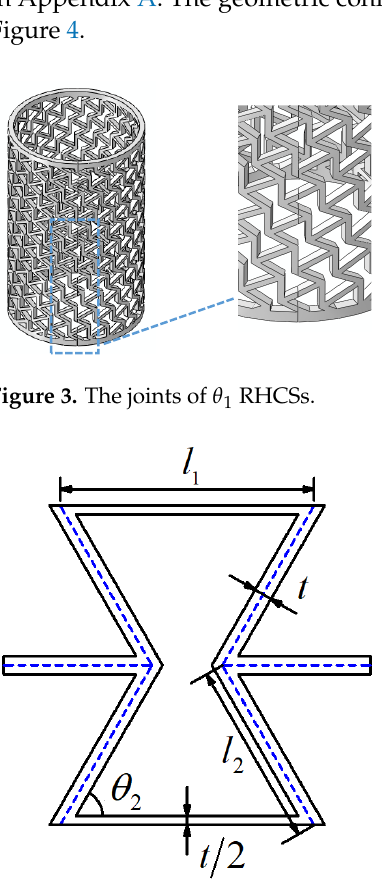
Figure 2. The process of constructing [ θ 1 / −θ 1 ] composite RHCS: ( a ) 0° re-entrant honeycomb cell; ( b ) θ 1 re-entrant honey- comb cell; ( c ) θ 1 re-entrant honeycomb layer; ( d ) θ 1 RHCS; ( e ) −θ 1 RHCS; ( f ) [ θ 1 / −θ 1 ] composite RHCS.